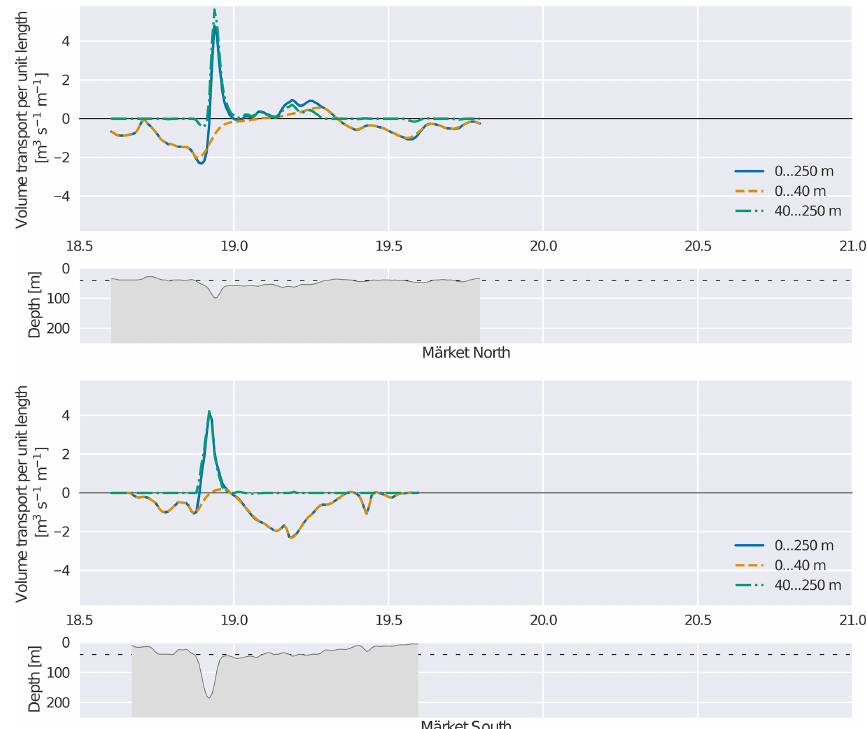
Figure 11. Volume transports per unit length along a transect, integrated over depth, from two northernmost longitudinal transects in the Åland Sea (MN and MS). Mean values for 2013–2017 shown. Positive values indicate northward transport. Values for the whole water column, the upper water column up to 40m and the lower water column below 40m are shown. In addition, for each transect a depth profile along the transect is displayed, with the 40m threshold marked with a dashed line. For reference, 1 ◦ longitude is here approximately 55km in